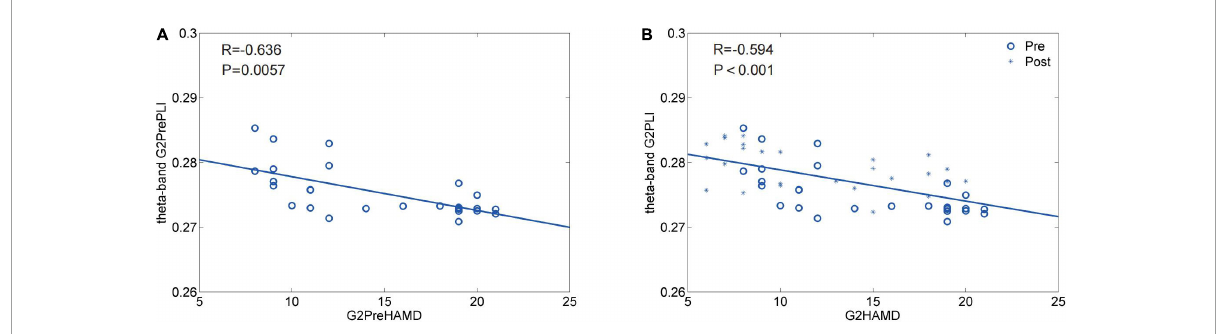
FIGURE11 (A,B) HAMD-24 score and EEG correlation analysis before and after treatment in both groups. G2 of the Qigong group Theta band pretherapy, By After correction p = 0.0057; It has relevance, R = − 0.636104330651571 negative correlation. G2 of the Qigong group Theta band post-treatment, By After correction p = − 8.446060534953326e-05, There was a significant correlation. R = − 0.593536751161075 had a negative